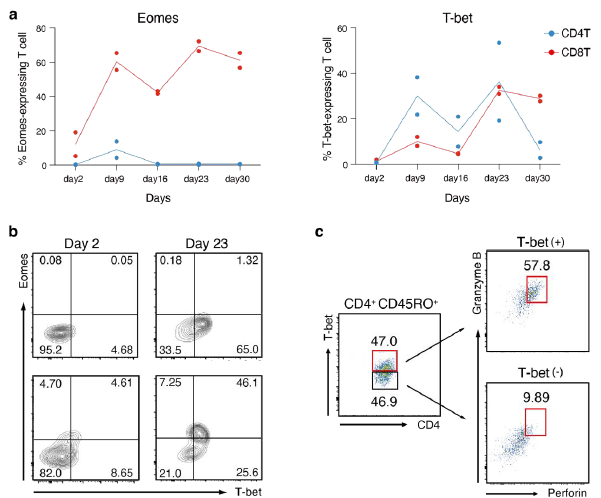
Figure 6. LCL-specific human CD4 + CTLs are characterized by low Eomes and high T-bet expression. ( a ) The percentages of Eomes-expressing (left graph) or T-bet-expressing (right graph) CD8 ⁺ T cells (in red) and CD4 + T cells (in blue) isolated from 2 healthy donors and co-cultured for the indicated time points with LCL (n = 2). ( b ) Representative contour plot of Eomes and T-bet expression of CD4 + T cells (upper panels) and CD8 + T cells (lower panels) on day 2 and day 23 post-culture from HD1. ( c ) Dot plot showing the gradient T-bet expression in CD4 + CD45RO + T cells at day 16 post-culture (left panel). Granzyme B and Perforin expression in T-bet high (right upper panel) and T-bet low (right lower panel) cell populations are shown. The gate delineates double-positive cells. ( a – c ) Representative data of more than two independent experiments are shown.